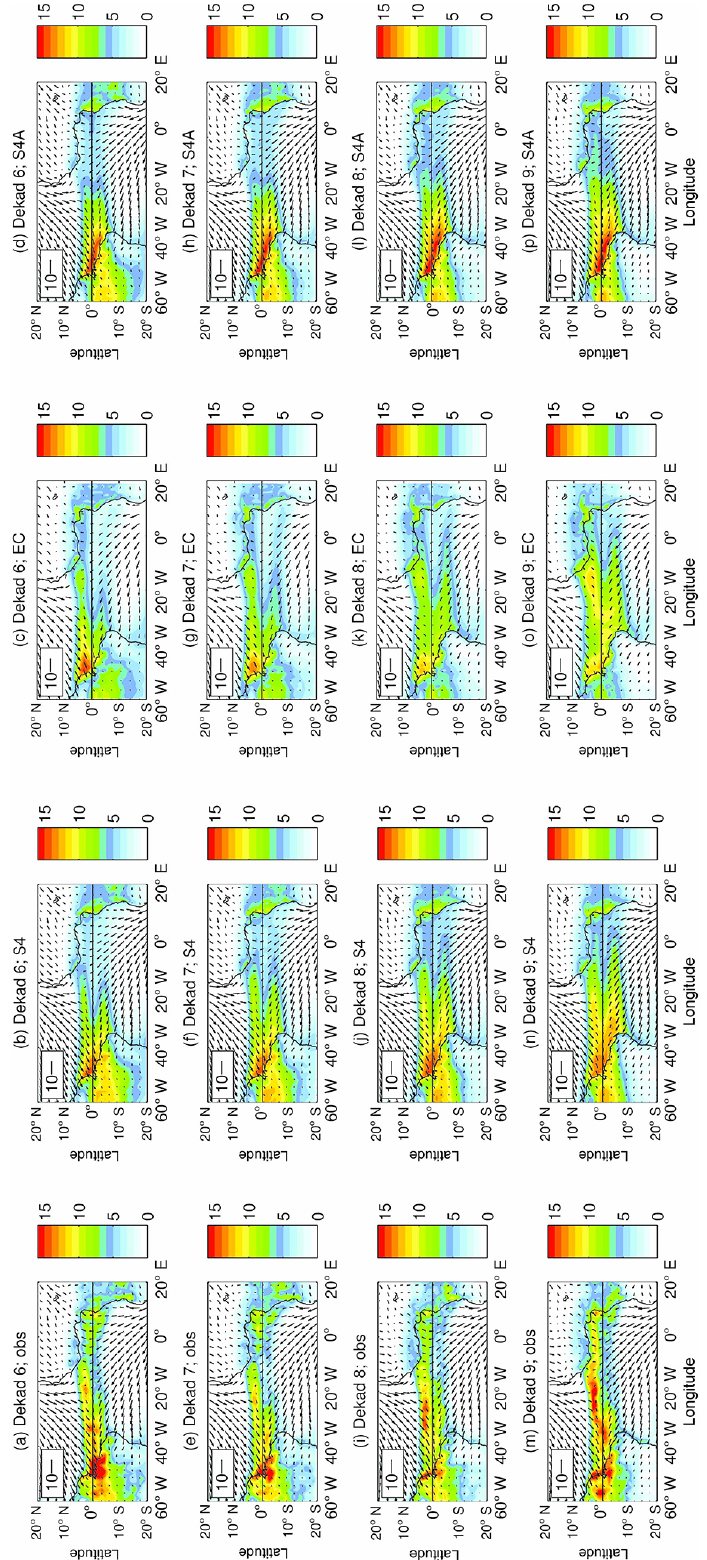
Figure 7. Maps comparing rainfall and wind at 10m in the observations and all three models. The observed panels (left column) show dekad-mean rainfall (filled contours, in mmd − 1 ) for the sixth to ninth dekads (10d periods) after 1 February, with wind at 10m (in ms − 1 ) as black arrows. The other three columns show the same for the three models, with data taken from the February